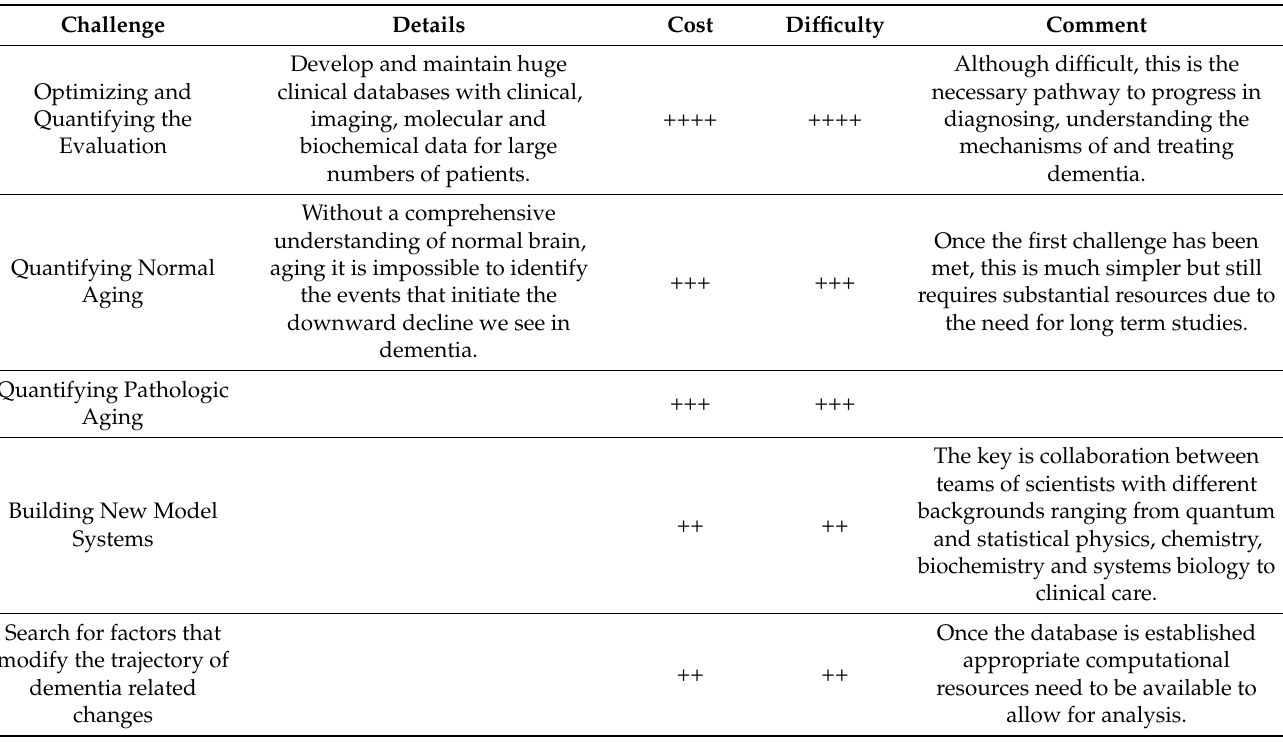
Table 1. Summary of Challenges in